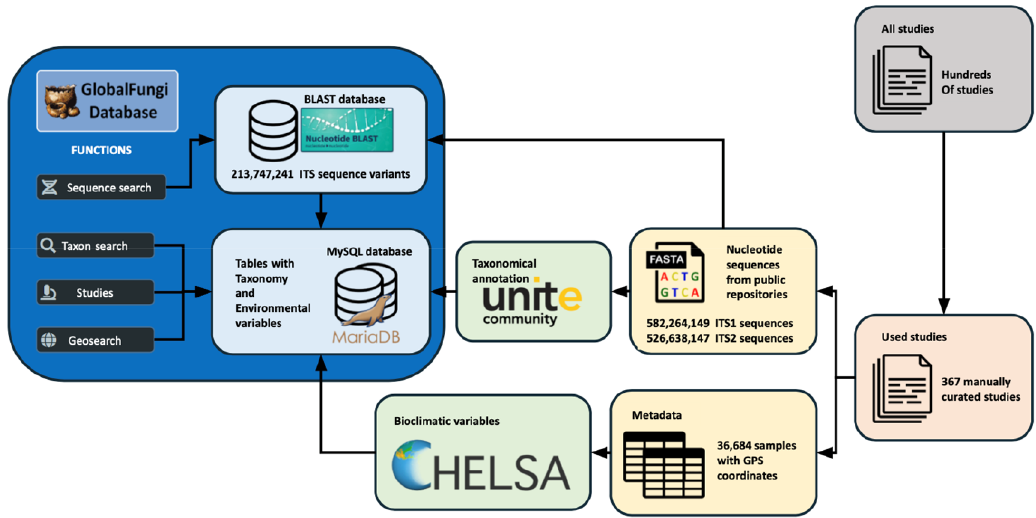
Figure 4. Data and annotation sources connected via the GlobalFungi Database. GlobalFungi enables searches for specific sequence variants, fungal genera, species, and molecular species (called ‘ species hypotheses ’ ) by performingBLASTn sequencesearches andquerying alocalMySQL database.Annotation oftaxaisbasedon UNITE, the database of fungal molecular taxa. Samples can be queried by searching on maps or through the studies where they were published. Climatic data for sample locations are retrieved from the CHELSA (Climatologies at High resolution for the Earth ’ s Land Surface Areas) database. ITS, Internal Transcribed Spacer; GPS, Global Positioning